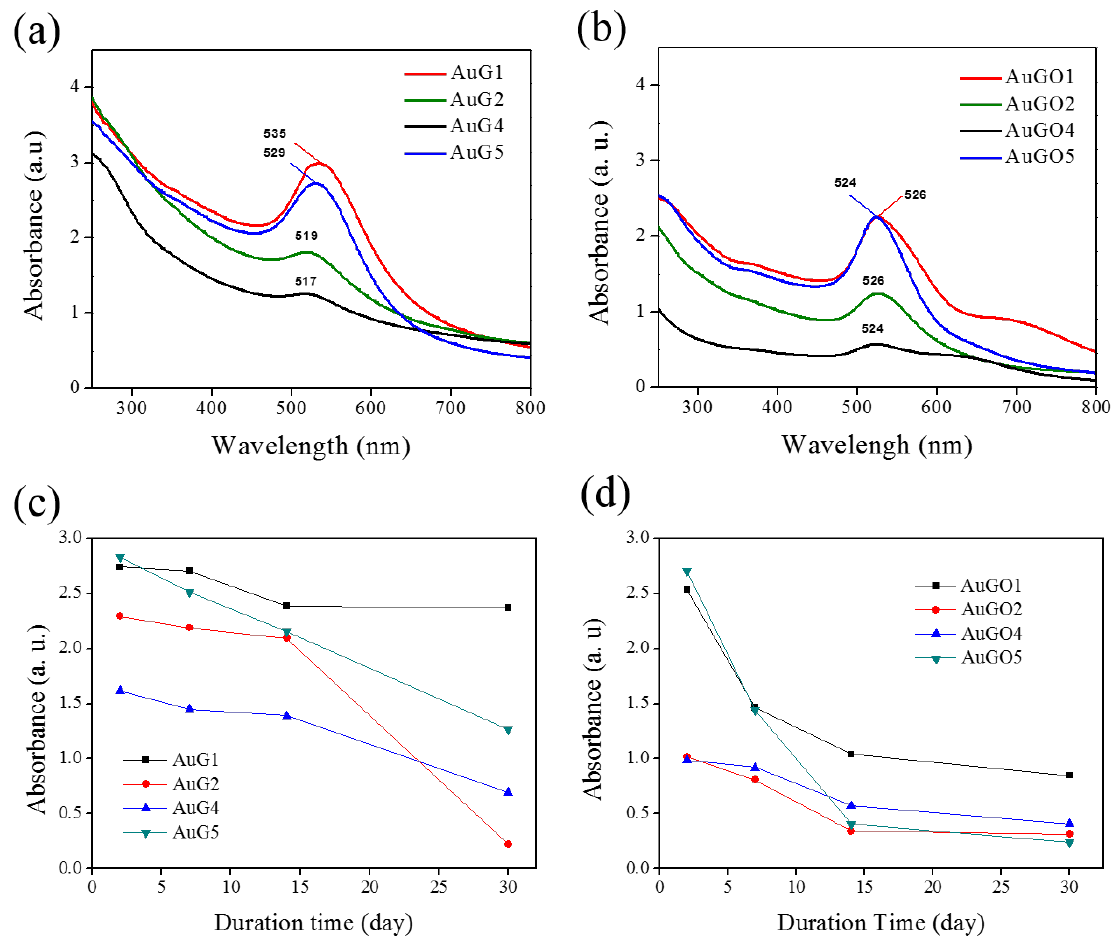
Figure 2. Characteristic absorption spectra of ( a ) Gr / Au NCPs and ( b ) GO / Au NCPs. Stability evaluation of ( c ) Gr / Au NCPs, and ( d ) GO / Au NCPs by recording the peak absorption of samples at different time intervals at room temperature.